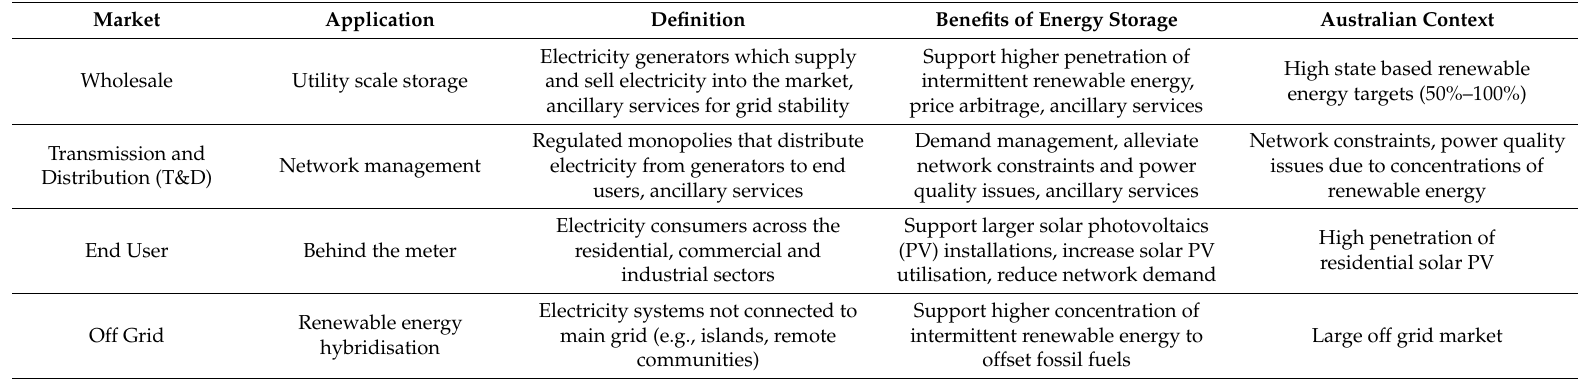
Table 1. Benefits of energy storage in the main energy market segments